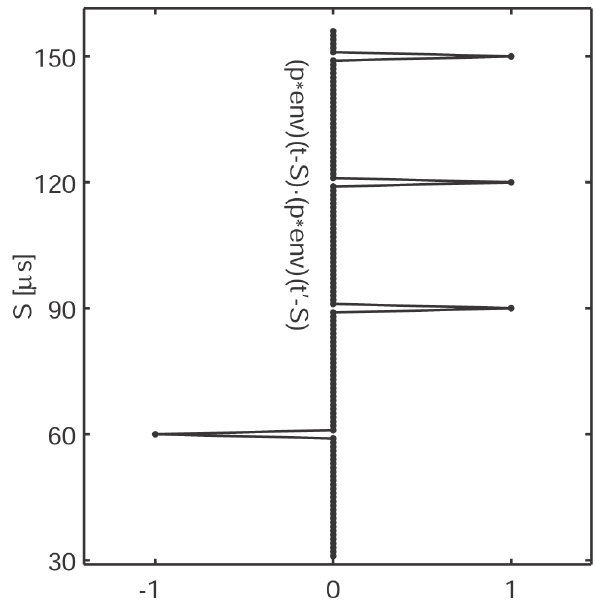
Fig. 4. The idealized range ambiguity function used in practice in defining the theory matrix A m for the 30- µ s